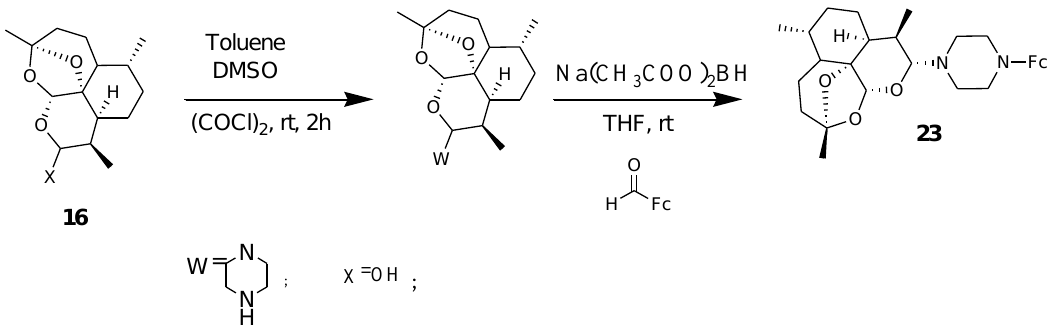
Figure 9. Synthesis of amino – artemisinin – ferrocene compound ( 23 ).